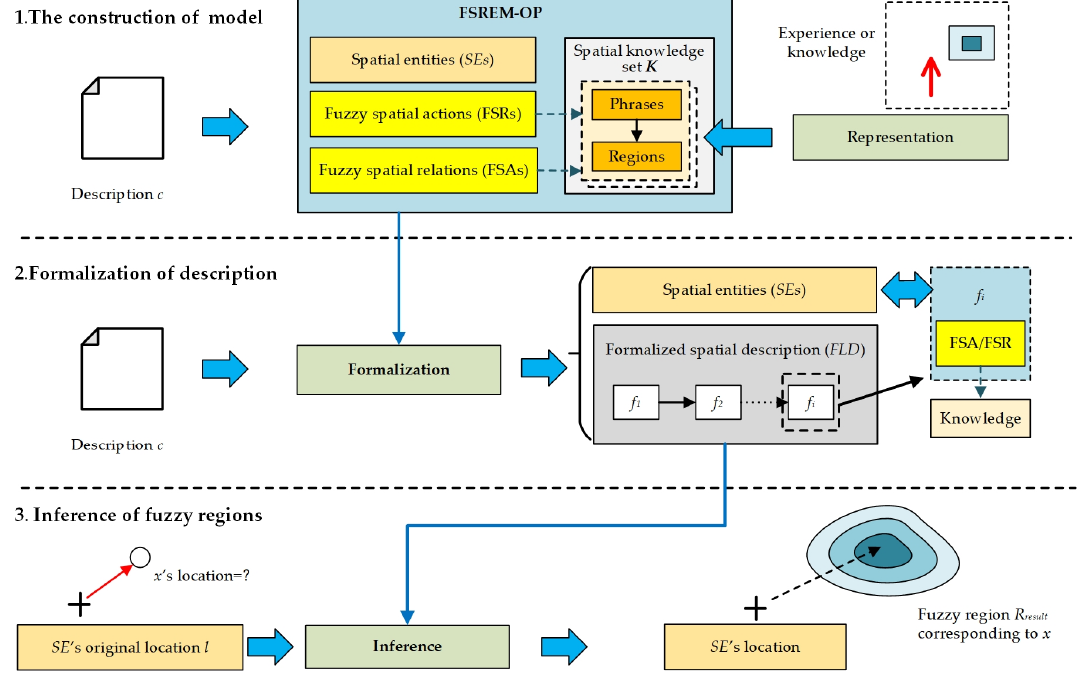
Figure 2. The overall process of FSREM-OP.